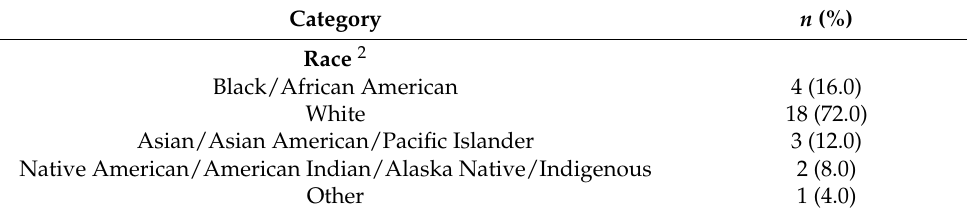
Table 1. Participant demographics ( n = 25 1